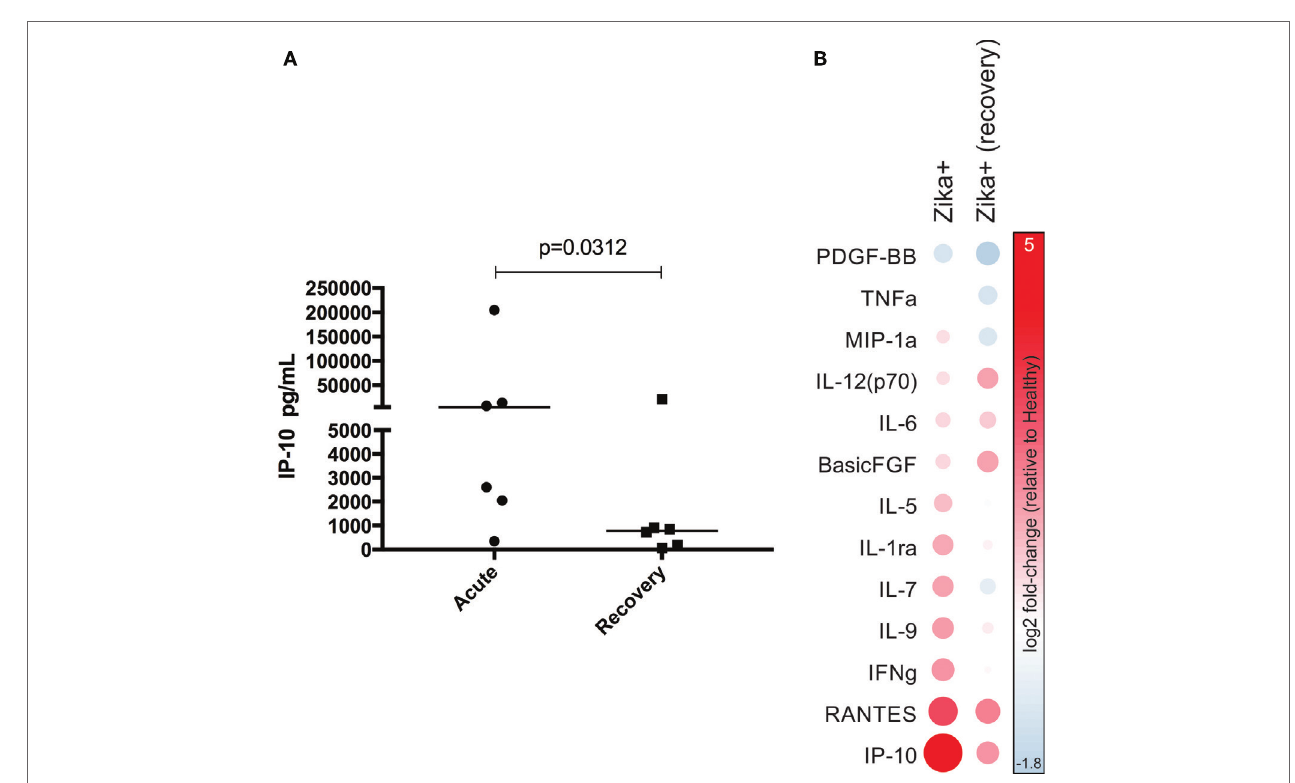
FigUre 6 | Comparison of plasma cytokine levels during the acute and recovery phases. (a) Cytokine measurements were performed in the plasma of six individuals in the recovery phase (2–3 weeks after the onset of symptoms) and compared to those performed during the acute phase. The dots on the graphs represent individuals. The Wilcoxon matched­pair test was used. p ­Values are indicated at the top of the graph and were considered significant when p = 0.0312. (b) The levels of cytokines with fold­changes > 2 over healthy control levels in the acute or recovery phases are represented. The node color represents the fold­change in cytokine levels between infected and healthy